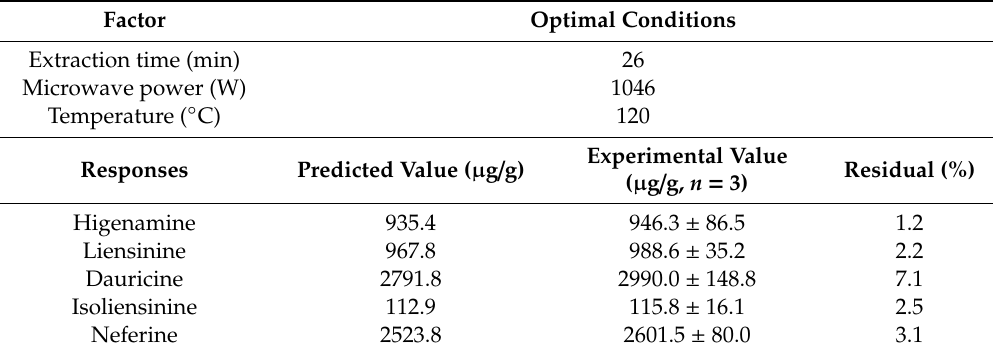
Table 3. Optimum of condition predicted and experimental value of response at the